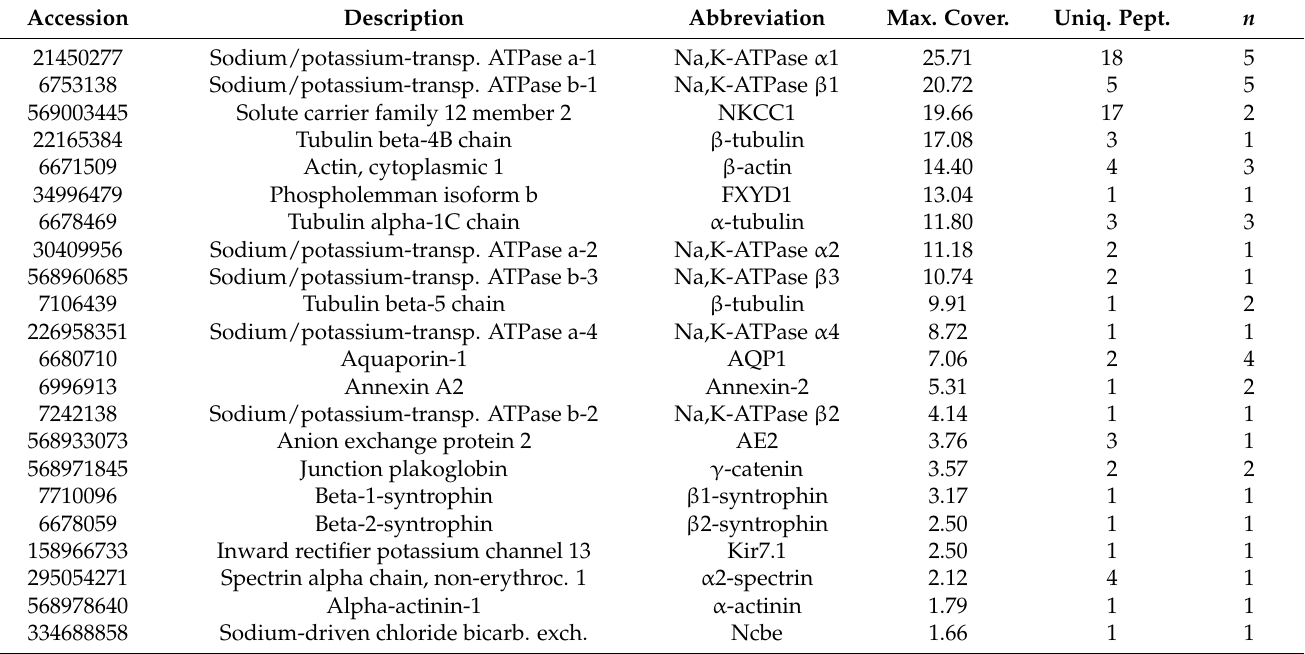
Table 1. Transport proteins, anchoring proteins, and cytoskeletal proteins co-immunoprecipitated by an anti-,K-ATPase α 1 antibody. Maximum sequence coverage (Max. Cover.), Unique peptides (Uniq. Pept.), number of identifications (of five replicates, n ).